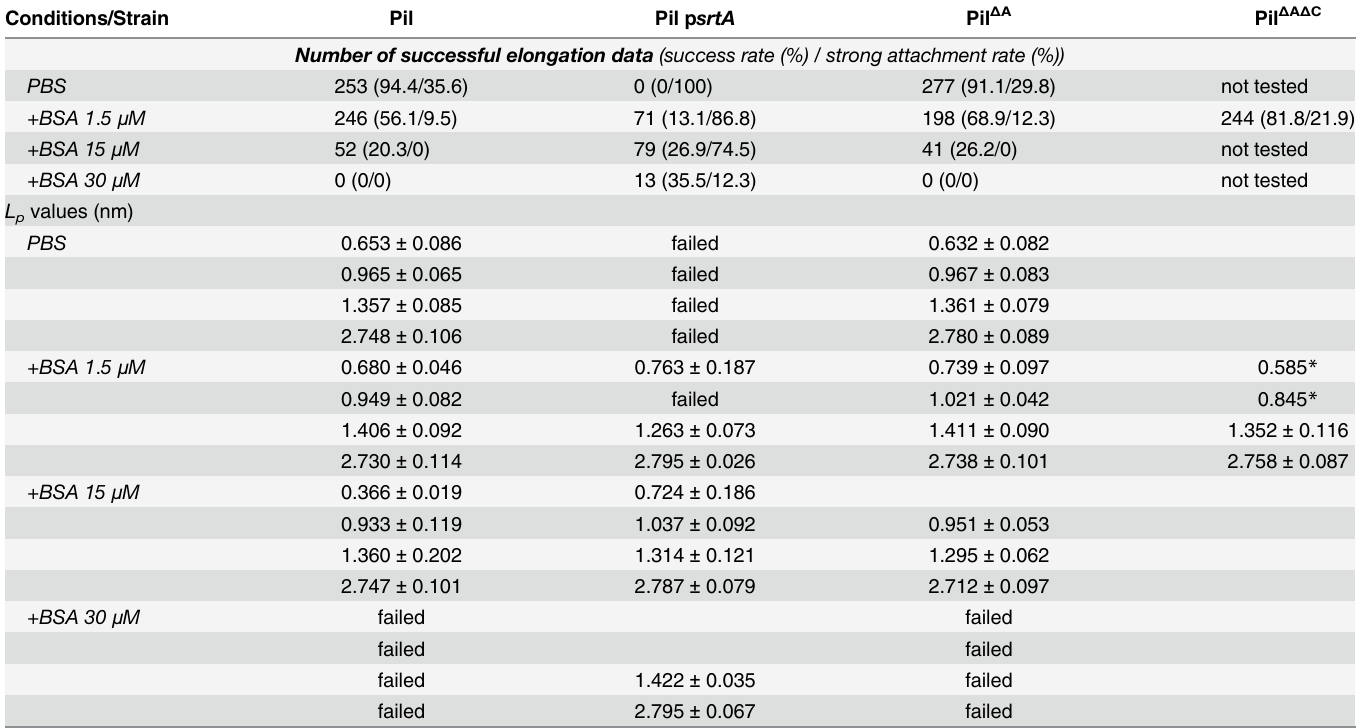
Table 2. Summary of FMOT dataset on the tested strains for which an elongation process was observed (i.e. Pil, Pil p srtA , Pil Δ A , and Pil Δ A Δ C ). Conditions/Strain